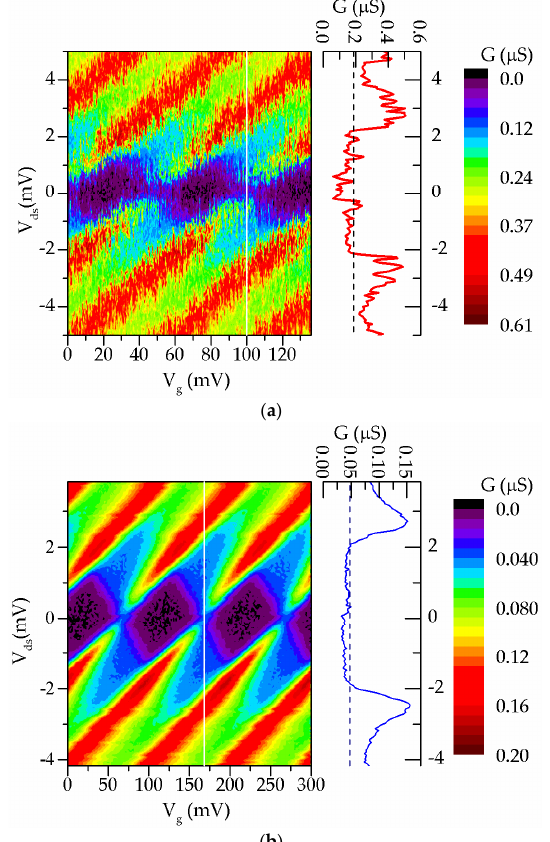
Figure 14. Comparison of electrical characteristics for Ni ‐ SiO 2 ‐ Ni devices measured at 0.4 K: ( a ) Coulomb diamonds of a device from batch A1 treated with double FGA along with a G ( V ds ) cross section at V g = 100 mV; and ( b ) Coulomb diamonds of a device from batch B1 treated with FGA+RHP along with a G ( V ds ) cross section at V g = 170 mV. The difference of CBO periods results from different device proximities to electrostatic gates, and hence a different gate capacitance.